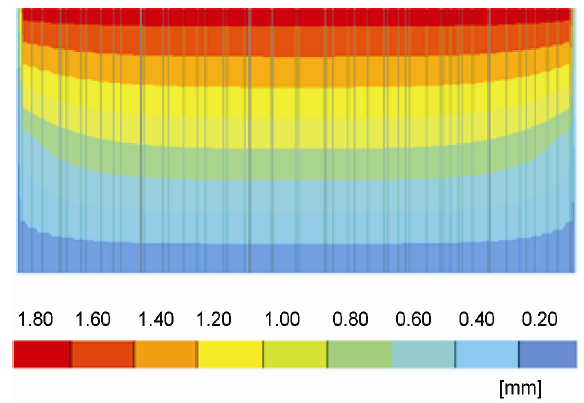
Fig. 19. Total displacement distribution in